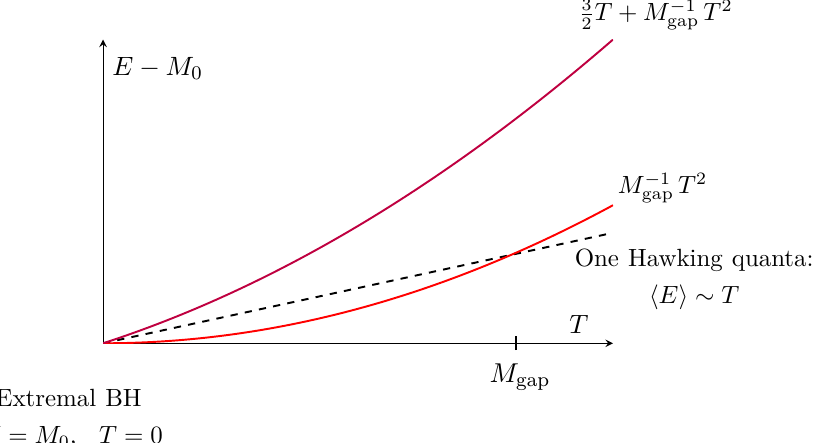
Figure 1. Energy above extremality at fixed charge as a function of the temperature when obtained from the semiclassical analysis (in red) and when accounting for the quantum fluctuations in the near-horizon region (in purple). This should be compared to the average energy of one Hawking quanta (dashed line) whose energy is on average h E i ∼ T